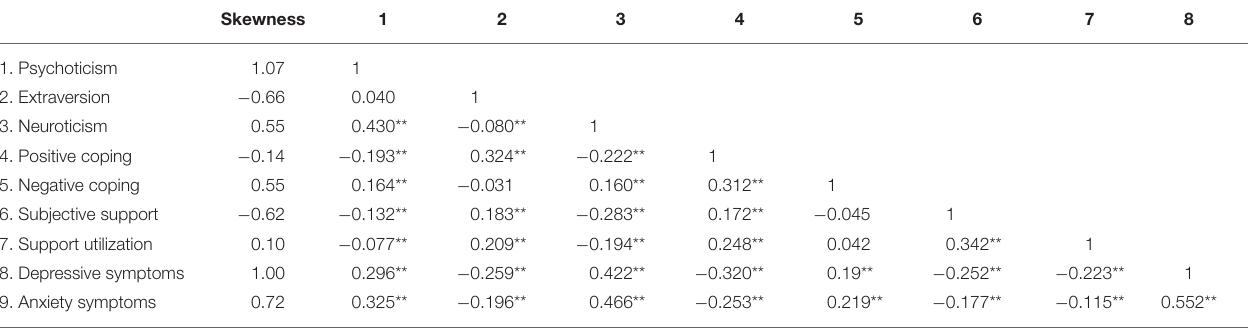
TABLE 1 | Univariate correlations of study variables ( N = 1157). Skewness